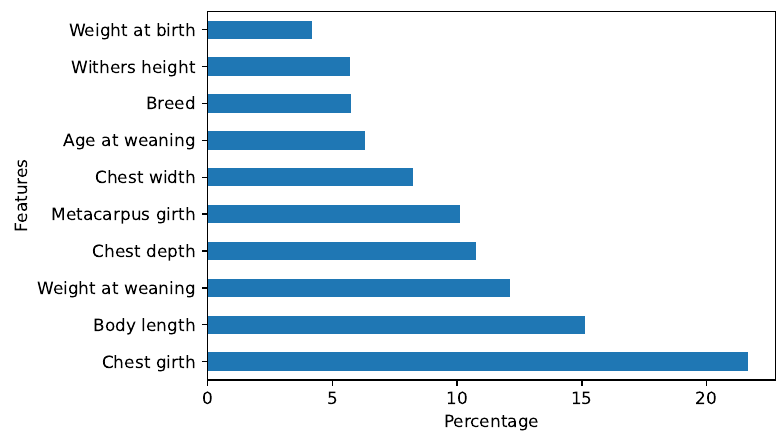
Figure 4. Feature importance identified by the StackingRegressor